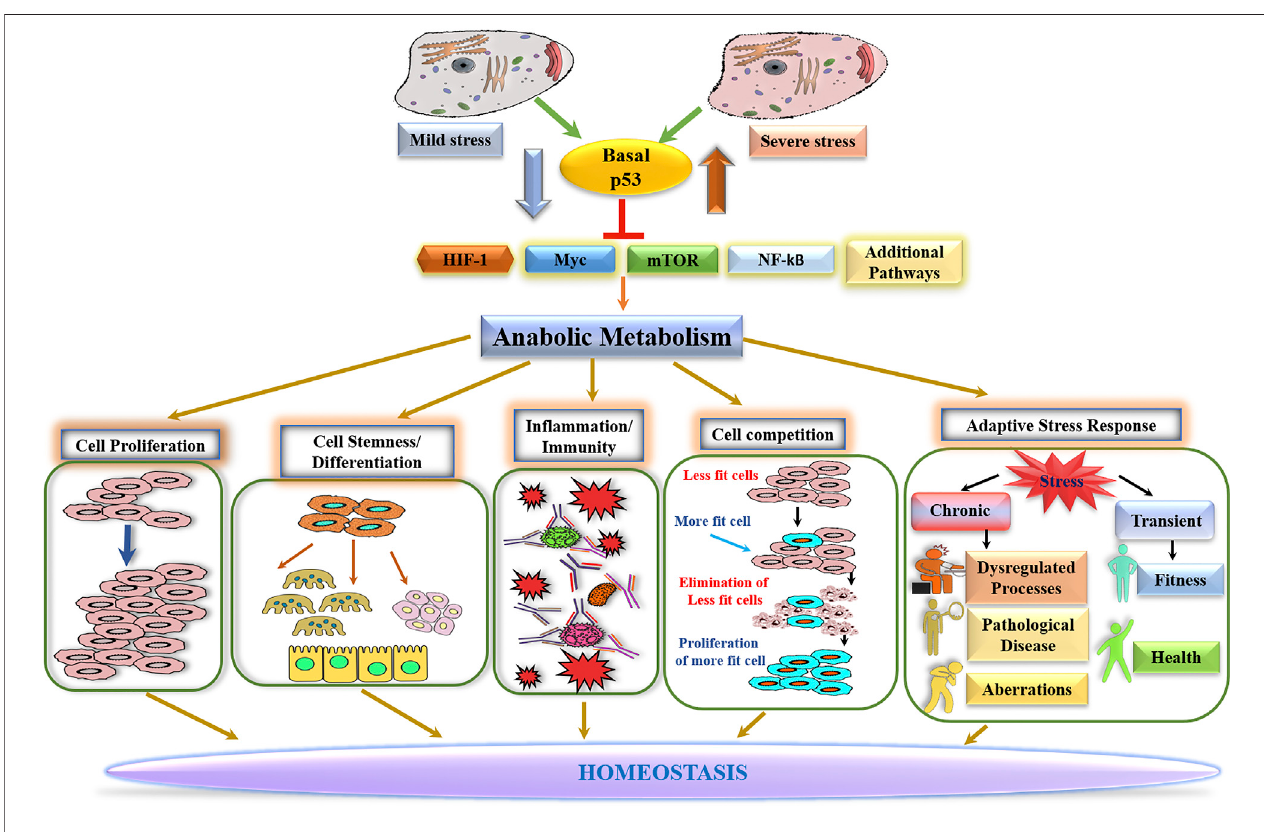
FIGURE 1 | Basal p53-mediated